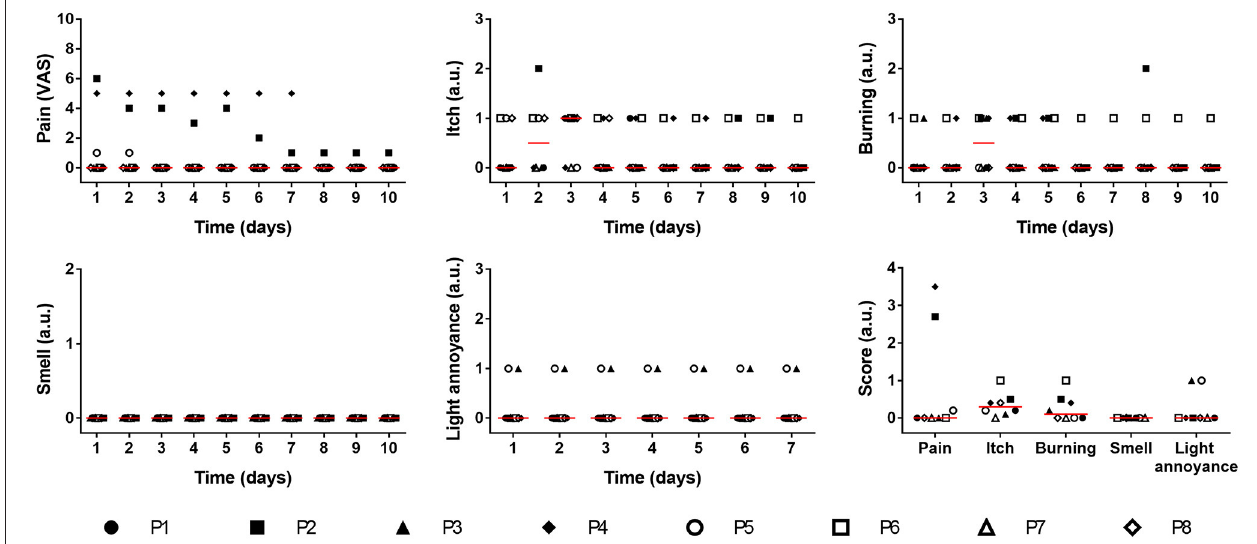
FIGURE 6 | Self-evaluation of treated patients. After implantation of the photosynthetic scaffold several relevant parameters were evaluated by patients (P1–P8) for 10 days: pain intensity (expressed by the 0–10 visual analog scale), itch, burning (Proportional Likert scales 0–3) and smell (Proportional Likert scales 0–2). Light annoyance (Proportional Likert scales 0–3) was evaluated for 7 days. Average score for each parameter is also shown. Data is shown for each patient and red line represents the median. Kruskal–Wallis test was used, and no significant differences were observed between days.